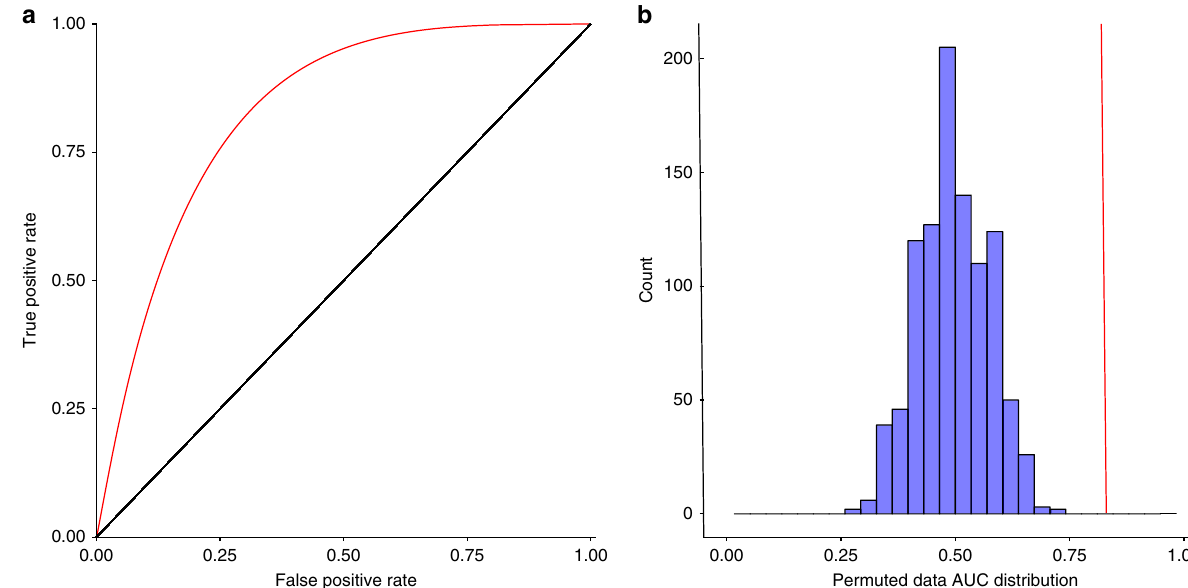
Fig. 2 Model assessment on an unseen test set. a The ROC AUC of the model scores on an unseen test set. b A histogram of 1000 AUCs calculated using permuted model scores against the unseen test set representing the null AUC distribution. As expected for a well-calibrated assessment, the null AUC distribution is centered on 0.5, indicating random separation. The AUC for the correct model scores, 0.83, is indicated with a red